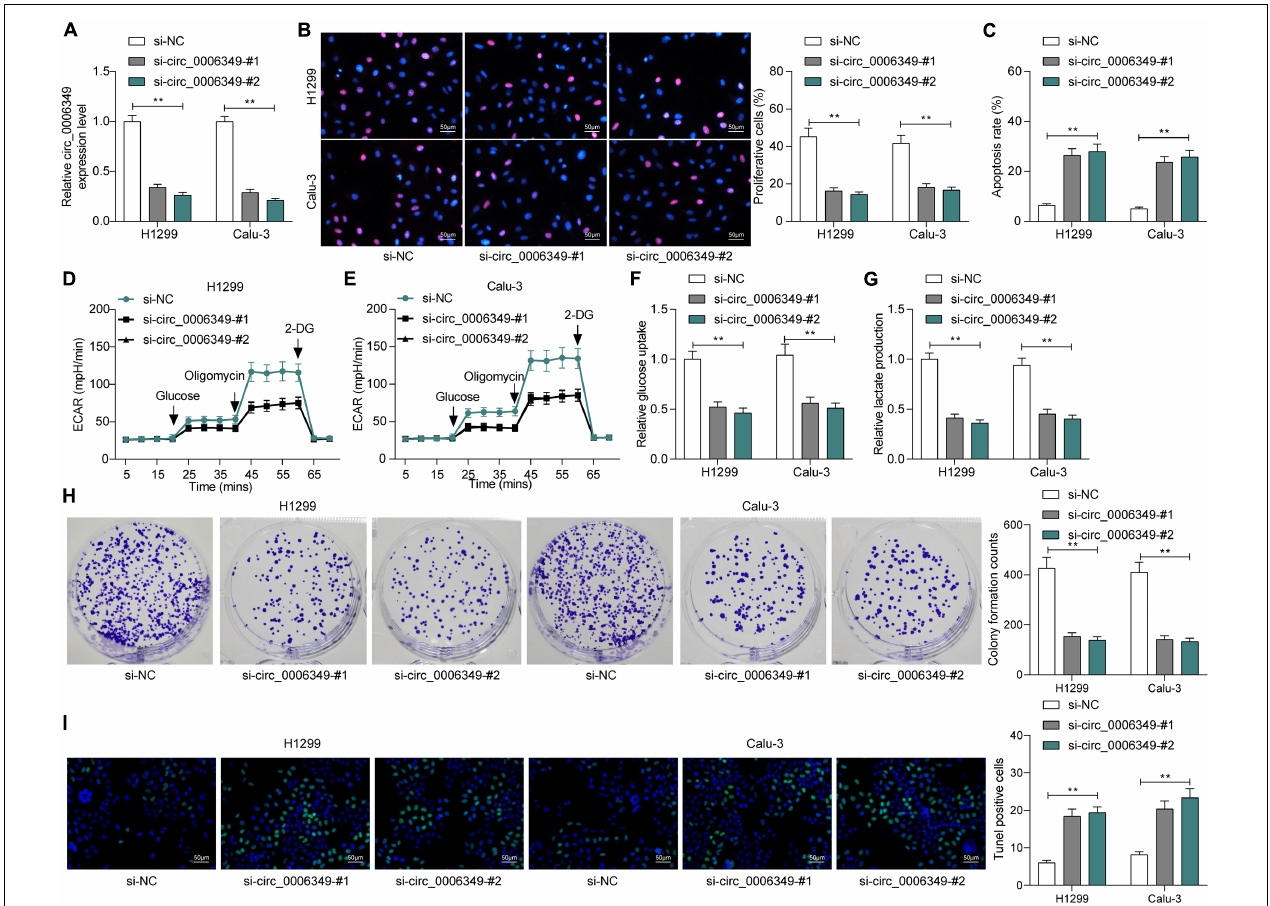
FIGURE 2 | Silencing of circ_0006349 suppresses the malignant behaviors of NSCLC cells. (A) transfection efficacy of si-circ_0006349-#1 and si-circ_0006349-#2 in H1299 and Calu-3 cells determined by RT-qPCR; (B) DNA replication activity of H1299 and Calu-3 cells measured by EdU labeling assay; (C) apoptosis of H1299 and Calu-3 cells detected by the flow cytometry; (D,E) ECAR in H1299 and Calu-3 cells; (F,G) glucose uptake (F) and lactate production (G) in H1299 and Calu-3 cells; (H) colony formation ability of H1299 and Calu-3 cells examined by the colony formation assay; (I) apoptotic bodies in H1299 and Calu-3 cells examined by the TUNEL assay. Differences were compared by two-way ANOVA (A–C,F–I) . All data were presented as the mean ± SD from three independent experiments. ** p <